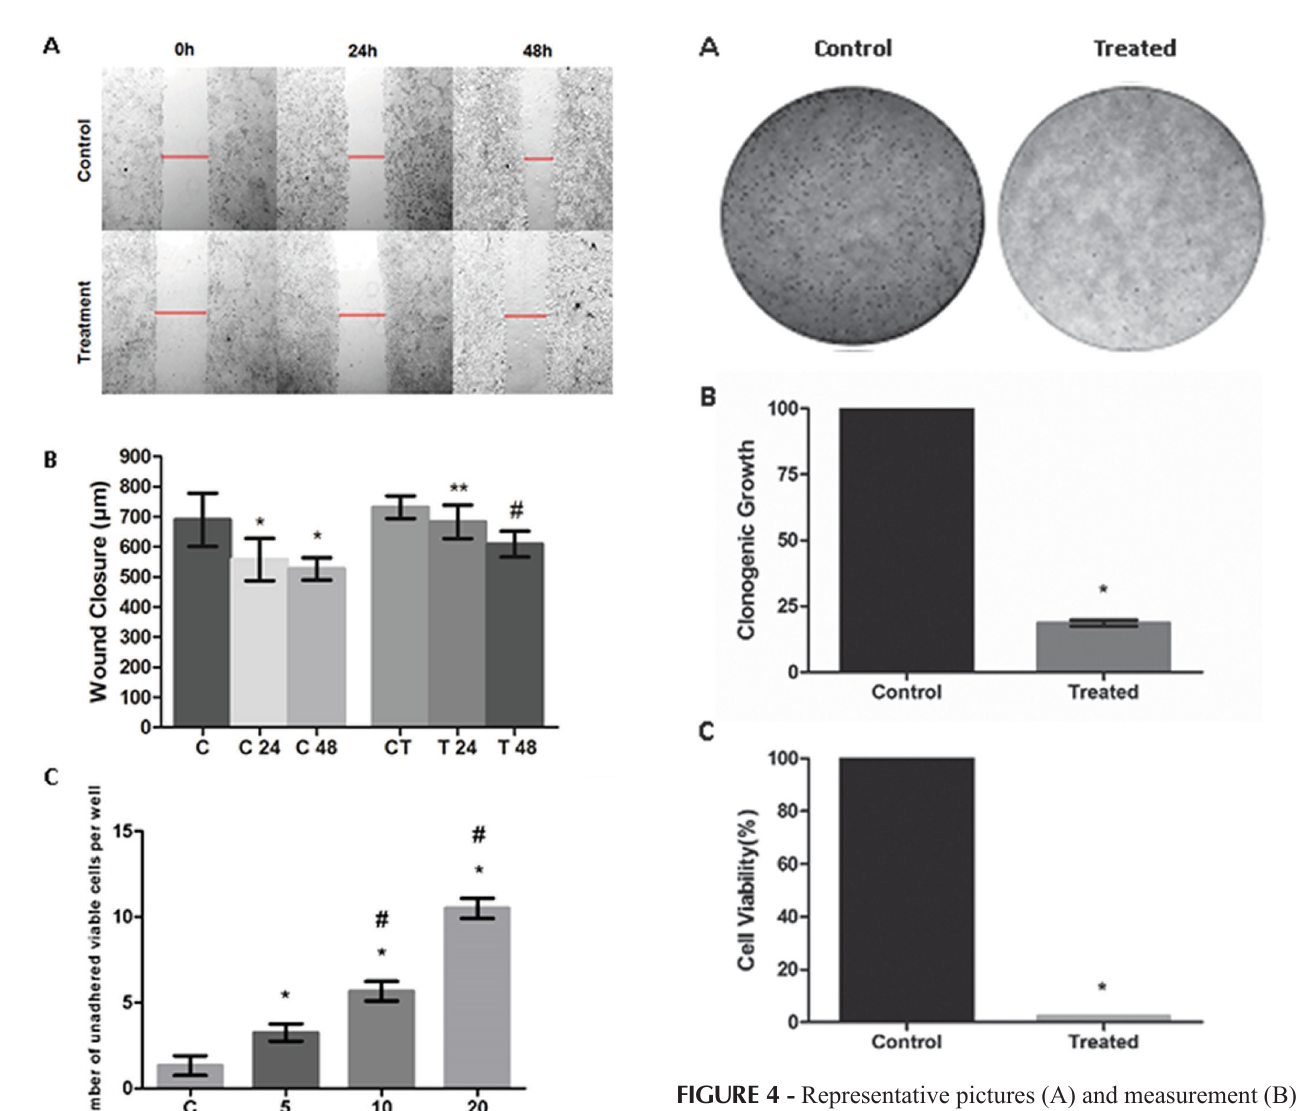
FIGURE 4 - Representative pictures (A) and measurement (B) of the effect of E. uniflora aqueous crude extract (7.8 mg/mL) on the clonogenic capacity of SiHa cells for 24 hours of treatment. (C) Analysis of the cell viability through the washout assay after 24 hours of treatment with the E. uniflora aqueous crude extract (at 7.8 mg/mL). Data show mean and standard deviation of 3 independent experiments performed in triplicate. * P <0.05 (One-way ANOVA followed by Tukey’s